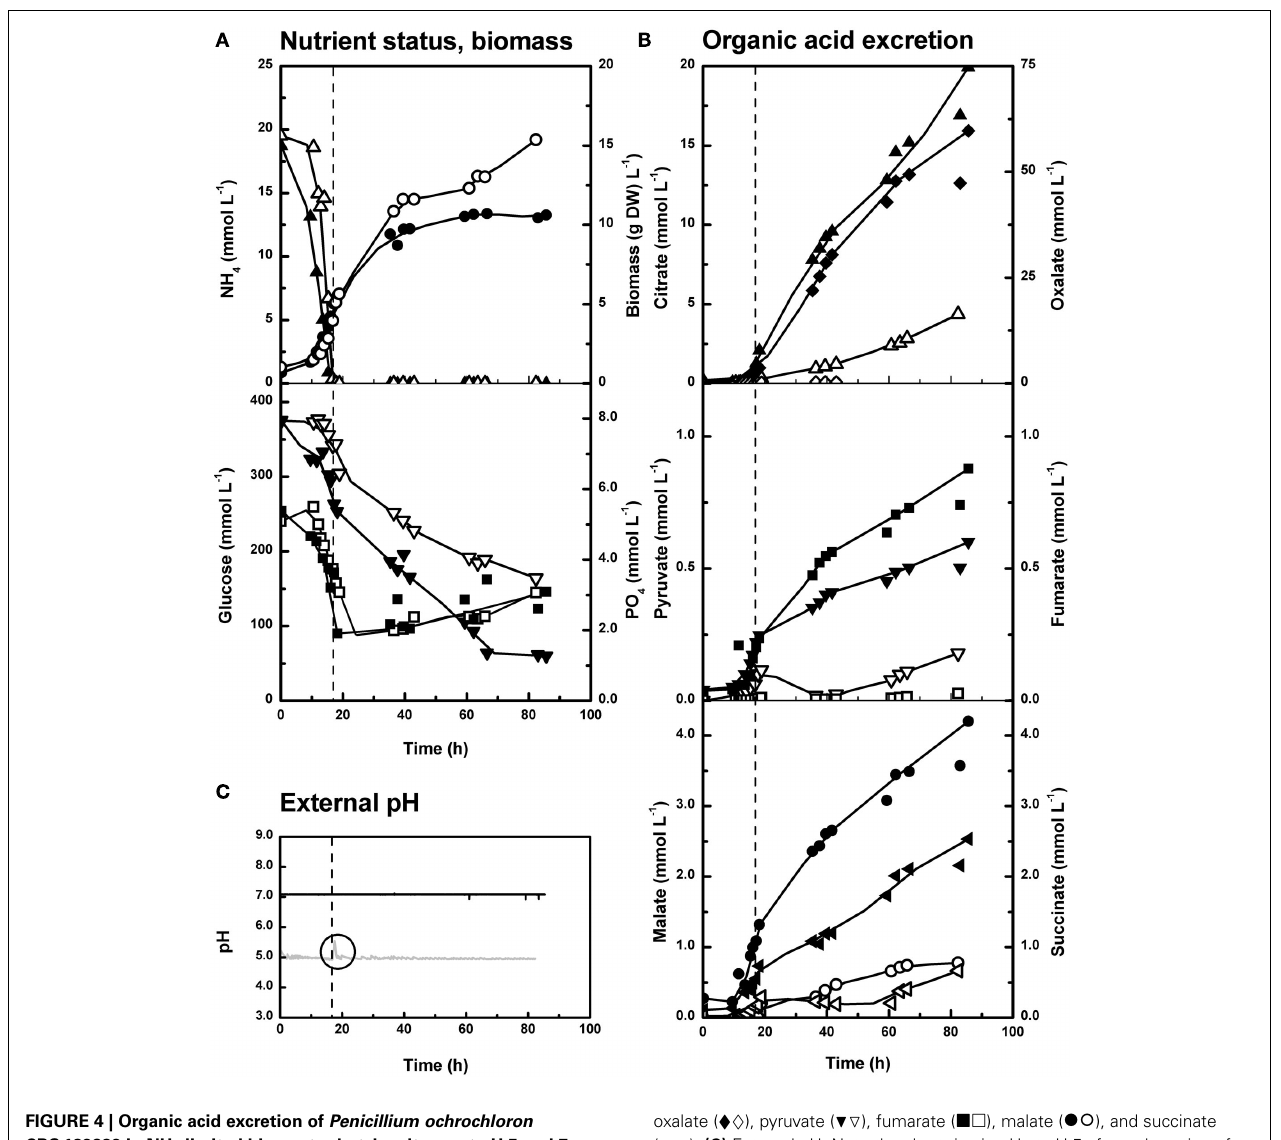
oxalate ( (cid:3)♦ ), pyruvate ( (cid:7)(cid:8) ), fumarate ( (cid:6)(cid:4) ), malate ( ( (cid:10)(cid:5) ). (C) External pH. Note the short rise in pH at pH 5 after exhaustion of ammonium. Representative experiments are shown. Average of three independent experiments from one specific time point of cultivation is depicted in Figure 3 (for pH 5 at 41.8 ± 1.38h and pH 7 at 39.3 ± 0.32h of